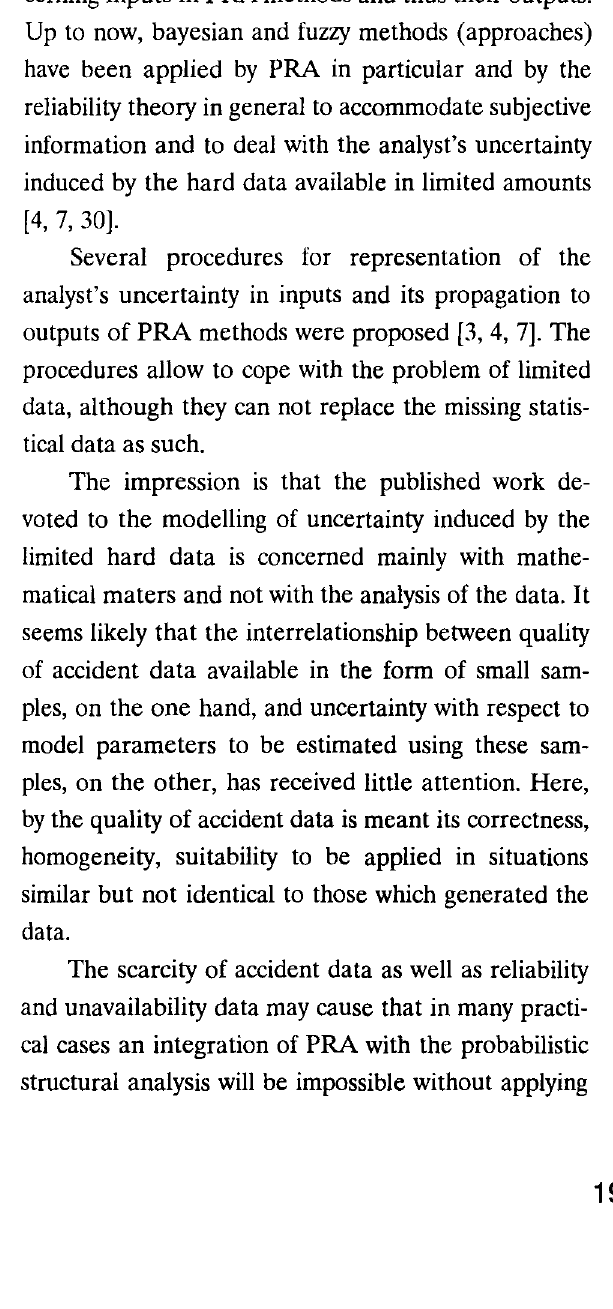
Fig 3. Categorisation of accidents including release of hazardous chemicals and selected from the data bank FACTS